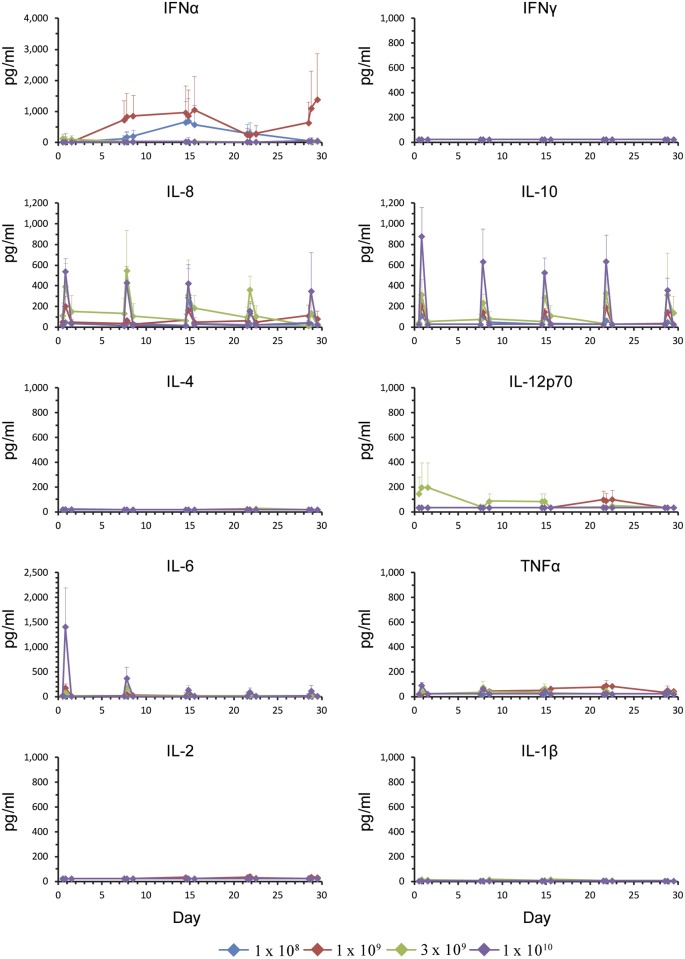
Cytokine response.At 4h post-dose, IL-6, IL-8, and IL-10 spiked and returned to normal by 24h post-dose. IFNα was elevated in certain patients for the duration of the study. The mean values (1x108, n = 5; 1x109, n = 5; 3x109, n = 4; 1x1010, n = 5) are shown for each dose level up to and including the MTD for Cycle 1 of treatment at pre-dose, 4h and 24h post-dose.